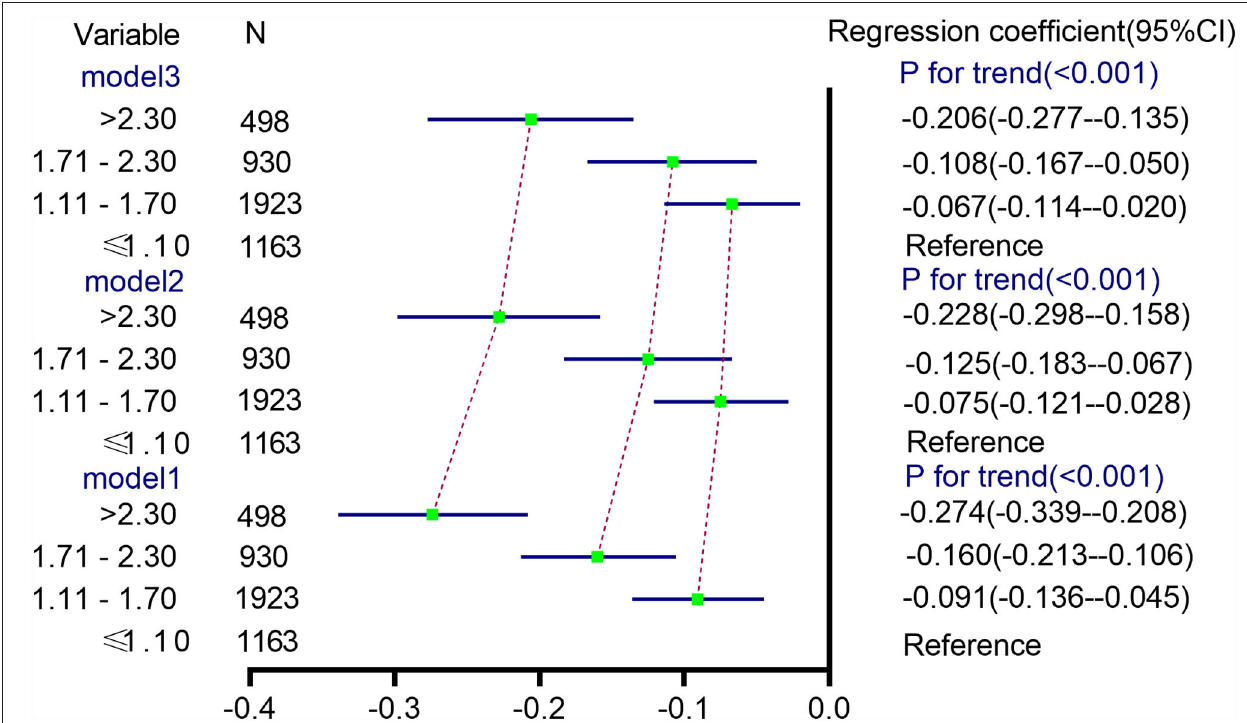
TABLE 3 | Logistic regression analyses demonstrating factors that contribute to test failure rate.